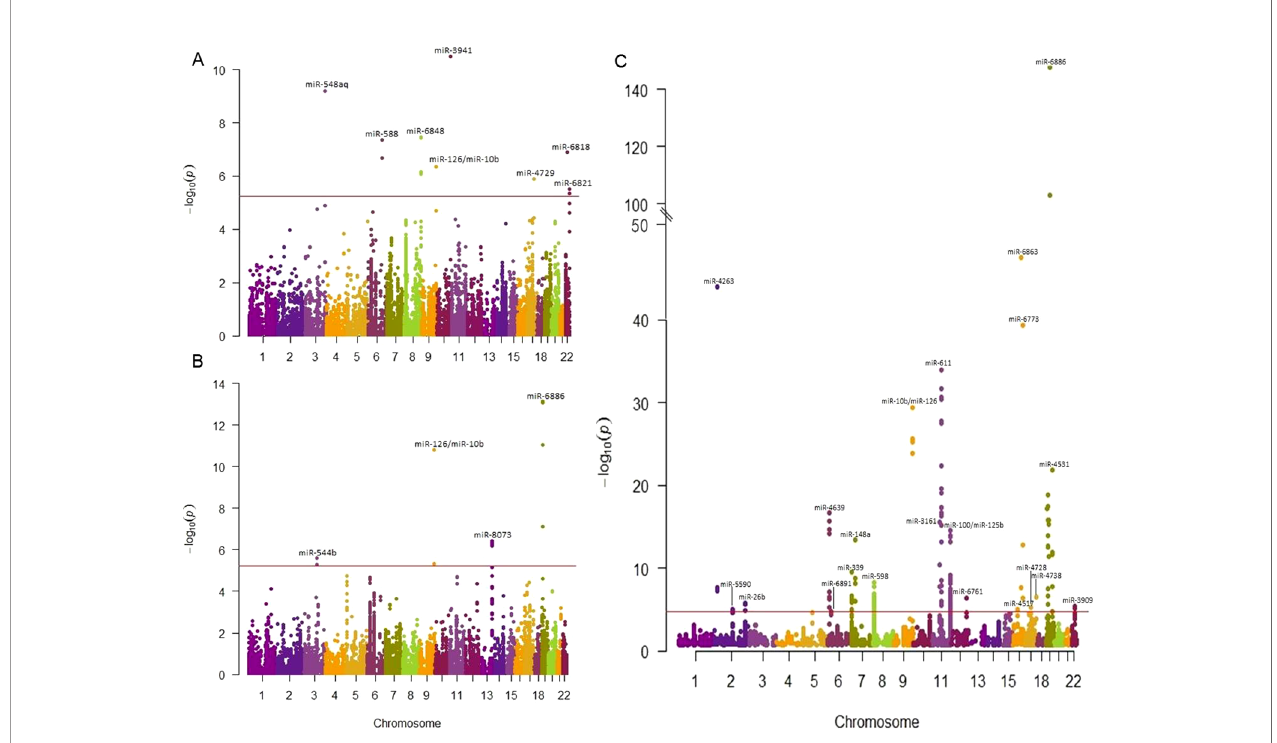
FIGURE 2 | Manhattan plots showing the association of miRNA-SNPs with T2D, CAD, and lipid traits. The association miRNA-related SNPs and cardiometabolic traits were examined using the publicly available GWAS data. We reported the most signi fi cantly associated miRNA of each SNP loci. The horizontal red line indicates the study signi fi cance threshold. (A) Manhattan plot showing the association of miRNA-SNPs with T2D in which 12 SNPs in 8 miRNAs passed the signi fi cant threshold. (B) Manhattan plot showing the association of miRNA-SNPs with CAD in which 13 SNPs in 9 miRNAs passed the signi fi cance threshold. (C) Manhattan plot showing the association of miRNA-SNPs with lipid traits in which 107 SNPs in 36 miRNAs passed the signi fi cant threshold. When SNPs were present in more traits, the most associated SNP was plotted.